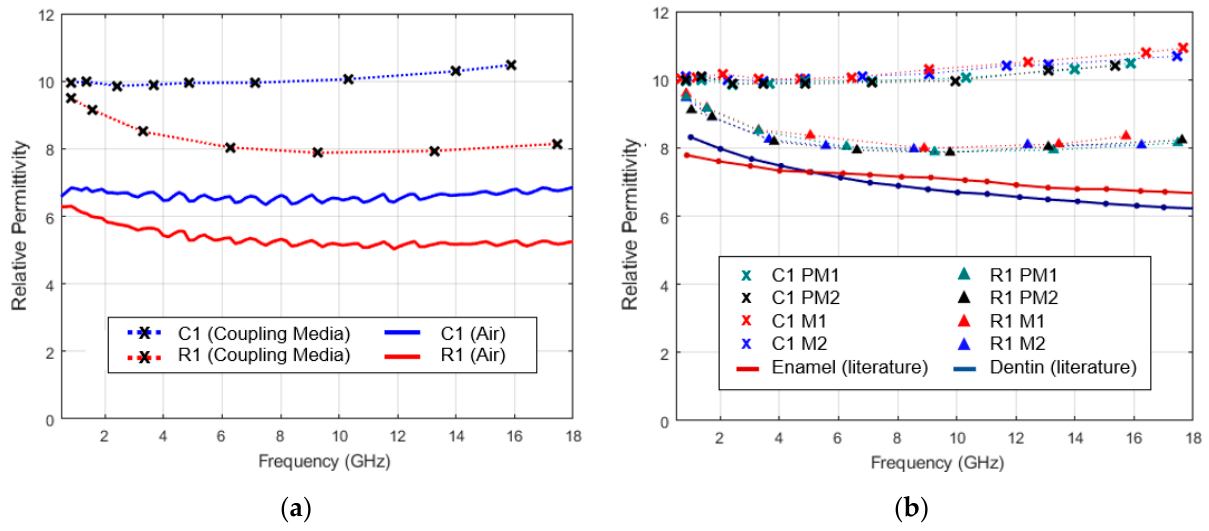
Figure 12. Comparison of the estimated relative permittivity: ( a ) with and without the application of coupling media; ( b ) with the relative permittivity available in the literature [37]. A total of four teeth were measured, two premolars (PMX) and two molars (MX), on the crown (C1, crosses) and root (R1, triangles) caries-prone areas. X denotes the sample identifier.